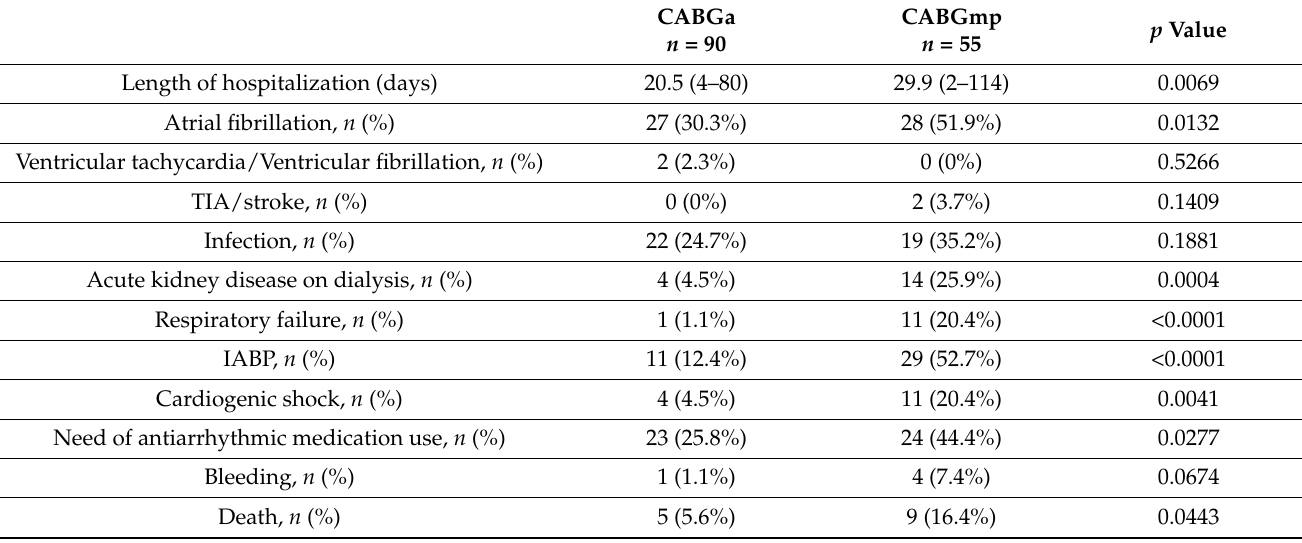
Table 4. In-hospital complications in patients with IMR treated by CABGa or